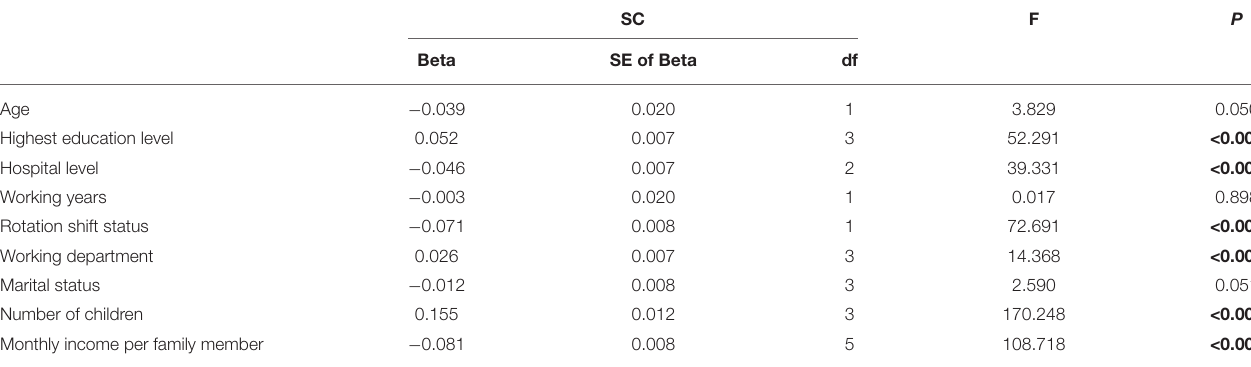
TABLE 3 | The outcome of coefficients table.